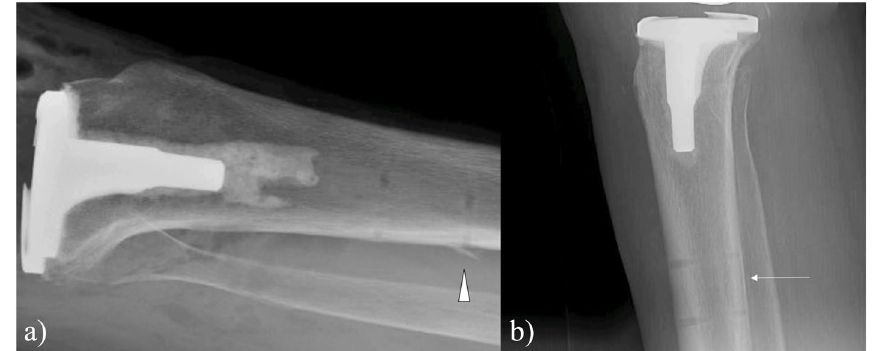
Fig. 3 a Lateral radiograph of a 70-year-old female with an intraoperative pin site cortical fleck (arrowhead) involving the distal tibial pin site of her right knee. b Lateral radiograph of an 83-year-old female with an intraoperative nondisplaced pin-site fracture of her right tibia as evidence by linear lucency (arrow) noted along the posterior aspect of the proximal tibial shaft between both pin sites. Both cases involved the large pin diameter robotic-assisted total knee arthroplasty system